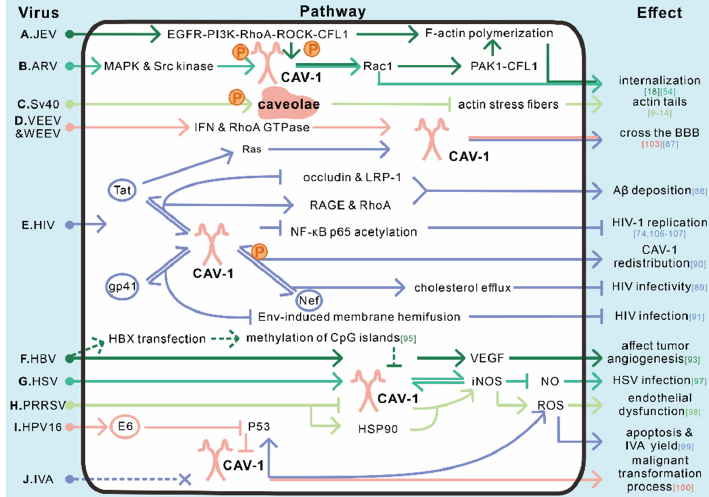
Figure 3. Summary of caveolae/CAV-1 in signal transduction during virus infection. A total of 16 caveolae and CAV-1-related signaling pathways from 11 viruses are shown in this figure. Di ff erent virusesandinvolvedsignalingpathwaysassociatedwithcaveolaeandCAV-1arerepresentedindi ff erent colors to distinguish among complex networks. ( A , B ) The internalization of the Japanese encephalitis virus (JEV) into SK-N-SH cells activates the EGFR-PI3K-RhoA-ROCK-CFL1 signaling pathway and leads CAV-1 phosphorylation and furthers Rac1 activation, thereby initiating PAK1-CFL1-mediated actin polymerization and JEV internalization [18]. The entry of Avian reovirus (ARV) also takes advantage of the phosphorylation of CAV-1 and Rac1 activation, while by activating p38 MAPK and Src kinase [54].